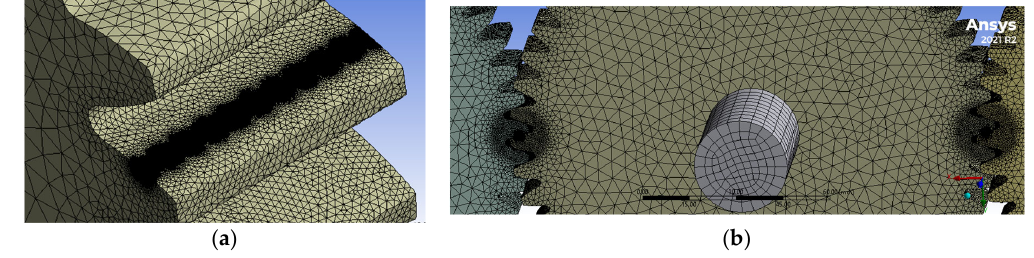
( b ) Figure 13. Boundary conditions. ( a ) Gear pair. ( b ) Torque split model. 9 ‐ 85 Nm torque for the gear pair and 170 Nm for the torque split are applied to the pin ‐ ion from one end in a certain period and the system is loaded. There is a 99% similarity between the analytical load distribution result as a result of the analysis performed in the single tooth region with the ANSYS ® finite element software given in Figure 14a. Gear contact loss is approximately half of the face width in the gear pair contact analysis. ( a1 )